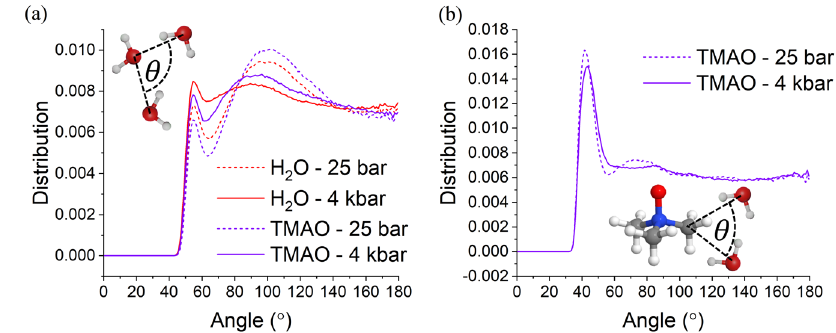
Fig. 4 Assessing tetrahedriality of water around water and TMAO. Triplet angle distributions for O w O w O w ( a ) and O w C T O w ( b ) triplets. Three atoms are part of a triplet if the two O w atoms are within a 3.38/4.48 Å from a central O w /C T atom which forms the apex of the triangle. The calculated angles are normalised to the sin θ dependence that would occur for a random distribution of angles